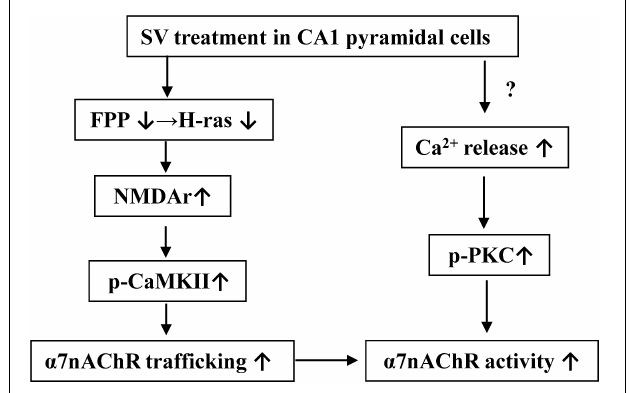
FIGURE 6 | The hypothesis of molecular mechanisms underlying the SV-enhanced α 7nAChR activity and trafficking. ↑ : increase; ↓ :